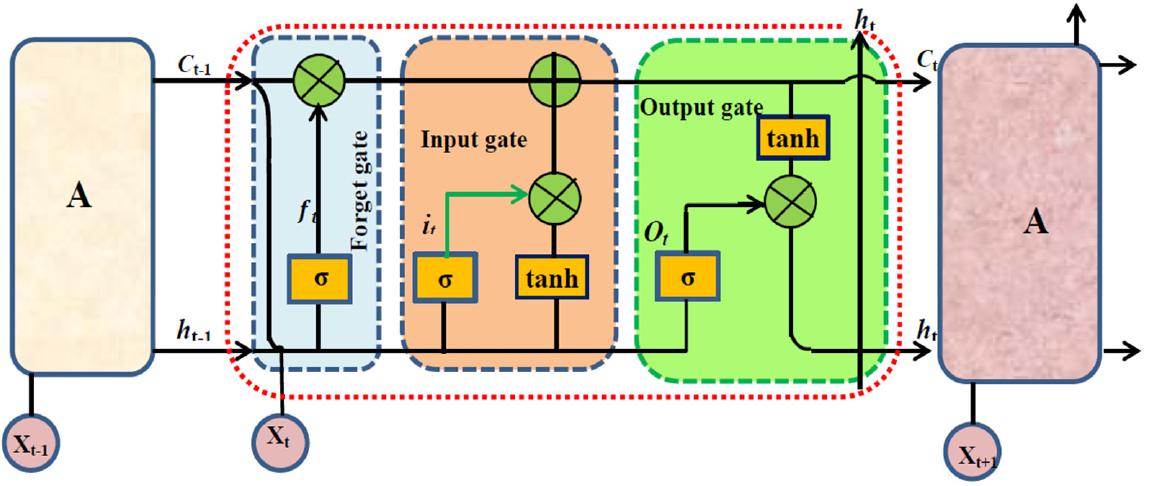
Figure 4. Main LSTM structure input and output.